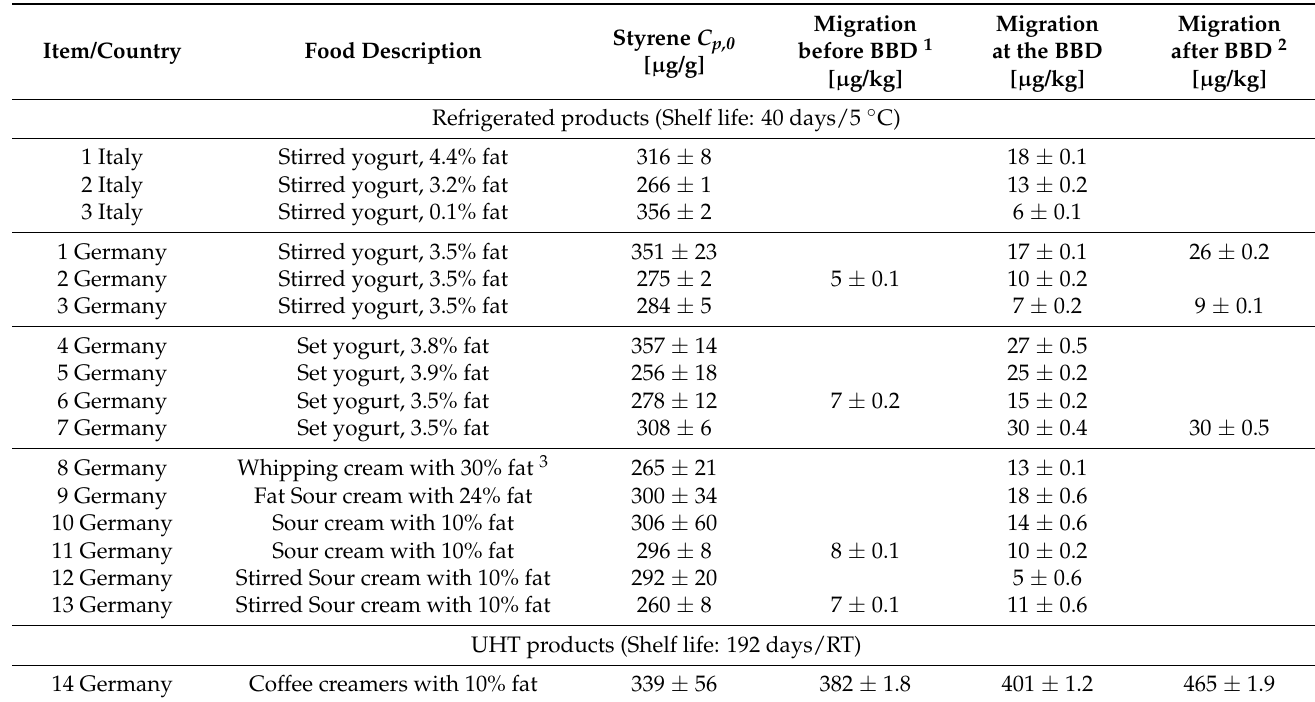
Table 4. Residual levels ( C p,0 ) in the PS packaging and migrated amount of styrene in food be- fore/at/after best before date (BBD).